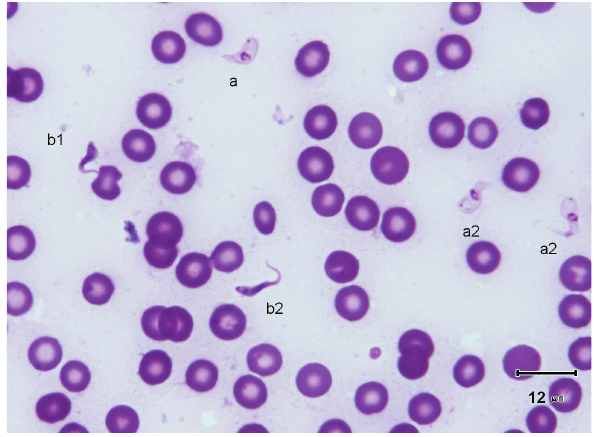
Fig. 6. – T. (Nannomonas) isomorph ( congolense -forms) without (b1) or with (b2) a free flagellum, and T. (Nannomonas) hyperpa- chymorph (a). Photo by Marc Desquesnes. The upper hyperpachymorph has a C-shaped flagellum (a2), and appears to be almost flat, like a